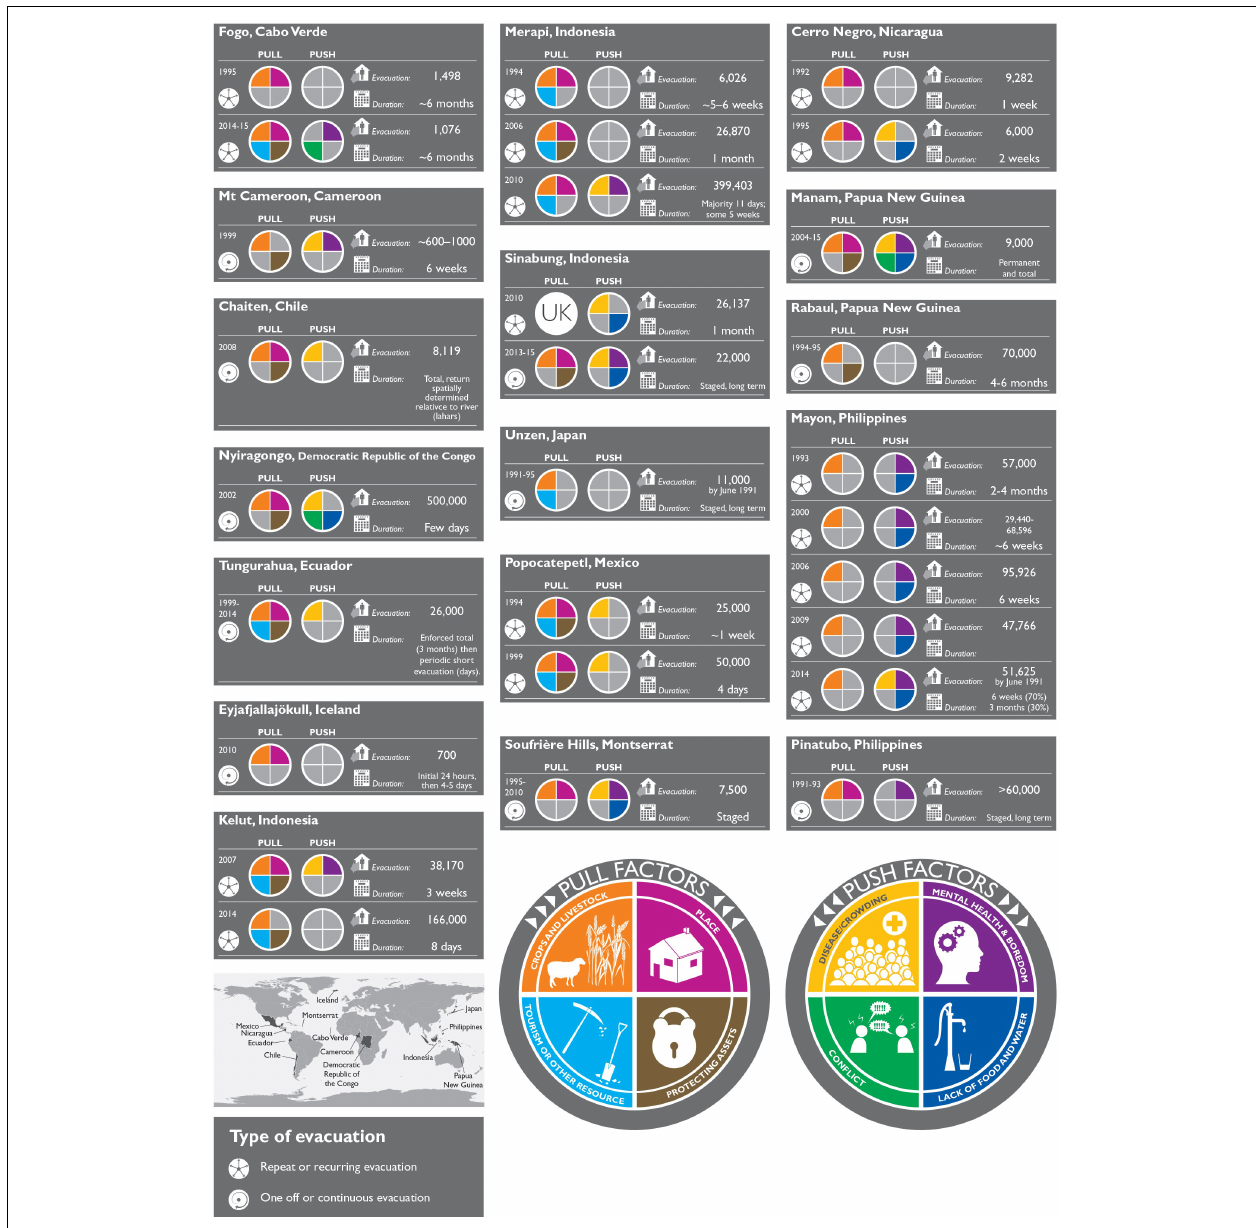
FIGURE 3 | Global comparison of pull–push drivers behind evacuations 1986–2015 where analysis of social drivers behind decision-making is available. Evacuations refers to peak no. of people evacuated, duration is typically median amount, return reporting is often less detailed. Further details are in Supplementary Tables . ‘UK’ in some segments mean ‘unknown’ (no analysis of push or pull drivers). Note here an absence of factors may mean an absence of reporting rather than lack of occurrence where one or two drivers have been